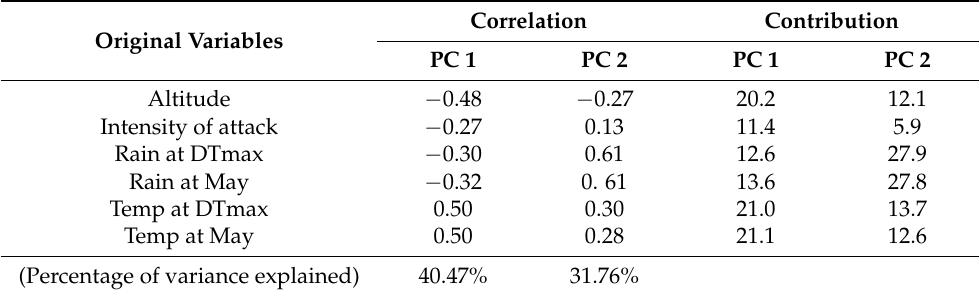
Table 1. Correlation between the original variable and the principal component PC1 and PC2 and their relative contribution (%).